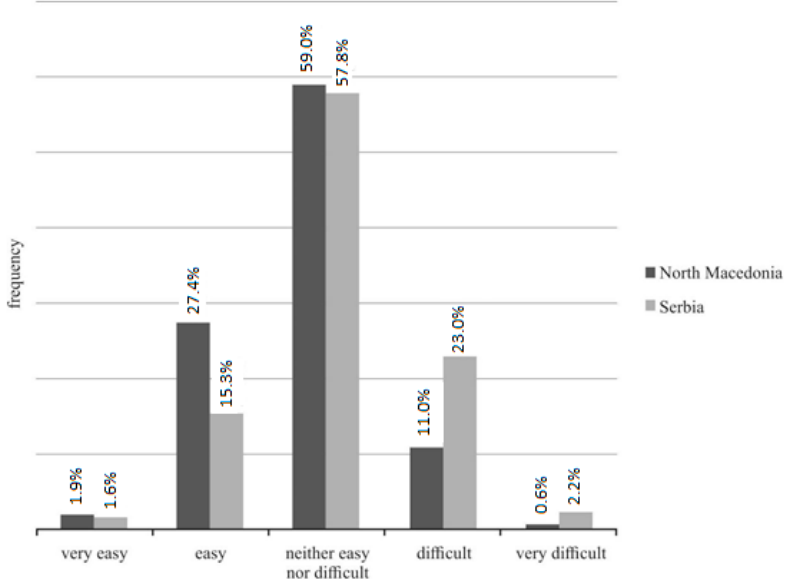
Figure 2. Students perceived mental effort of both countries.